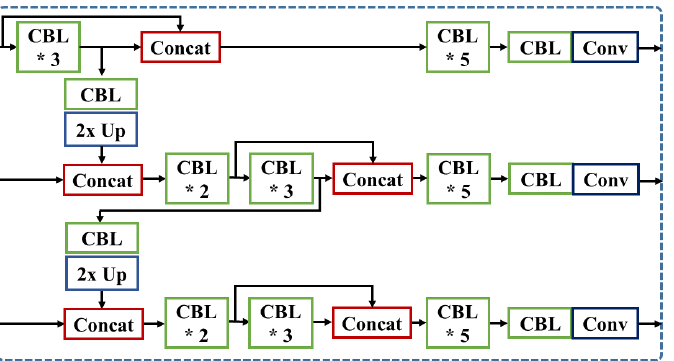
Figure 8. Detailed architecture of SCat. (’ ∗ ’ means the repetition of CBL).